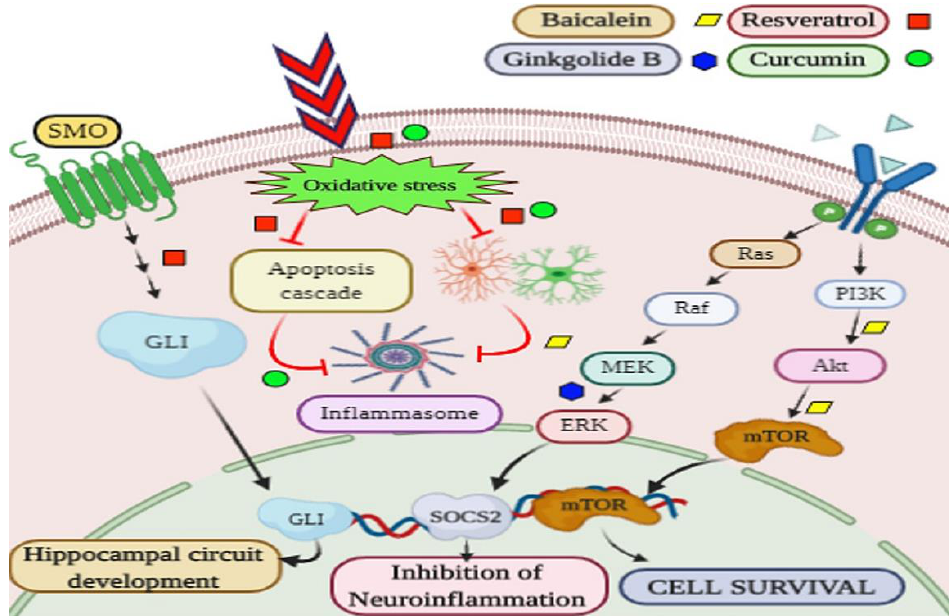
Figure 6. Overall pathogenesis of neuronal loss in ischemic stroke and their prevention by phytochemicals. Oxidative stress, found in the neurons of the ischemic brain is prevented by resveratrol and curcumin. These phytochemicals also prevent the inflammation and apoptosis induced by oxidative stress. Baicalein prevents the formation of inflammasome reducing inflammation and edema. Resveratrol activates SMO/GLI pathway leading to the development of hippocampal neuronal circuit. It also activates the PI3K/Akt/mTOR pathway leading to cell survival. Another phytochemical ginkgolide B acts on MEK/ERK/SOCS2 pathway causing inhibition of inflammation in